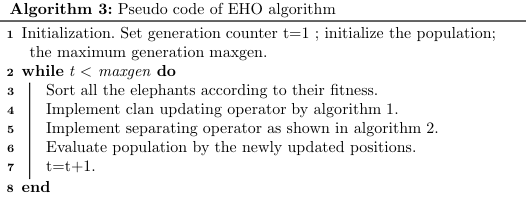
Algorithm 3: Pseudo code of EHO